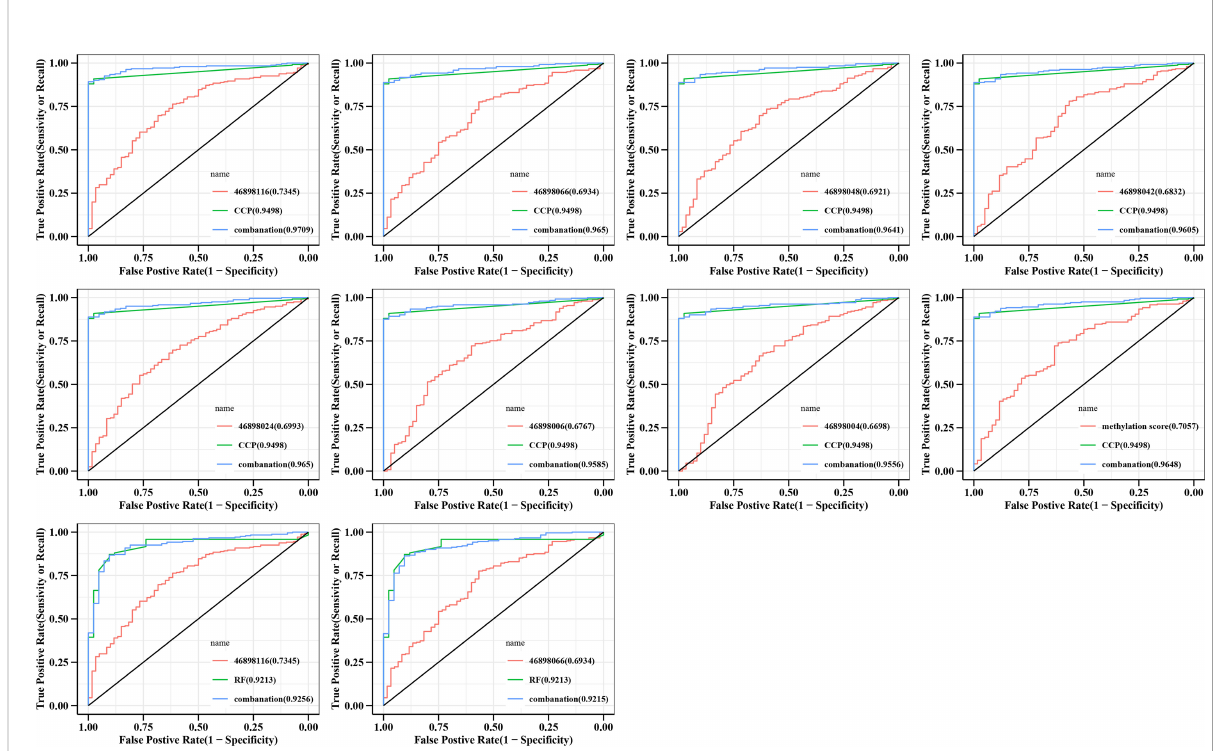
FIGURE 4 Speci fi city and accuracy of different CpG sites combined with RF or CCP for the diagnosis of RA. Logstic regression models were constructed and ROC curves were plotted, with the AUC area representing the accuracy and speci fi city of the diagnosis. CCP, anti-cyclic peptide containing citrulline; RF, rheumatoid factor; combanation, different CpG sites combined with RF or